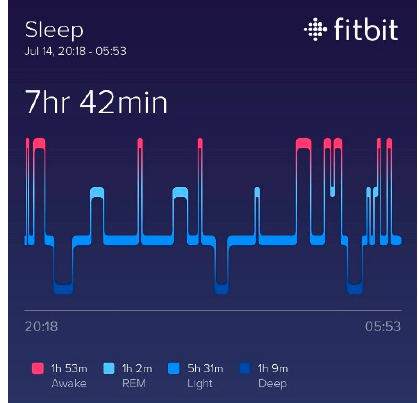
Figure A22. Chiang Mai, Thailand.